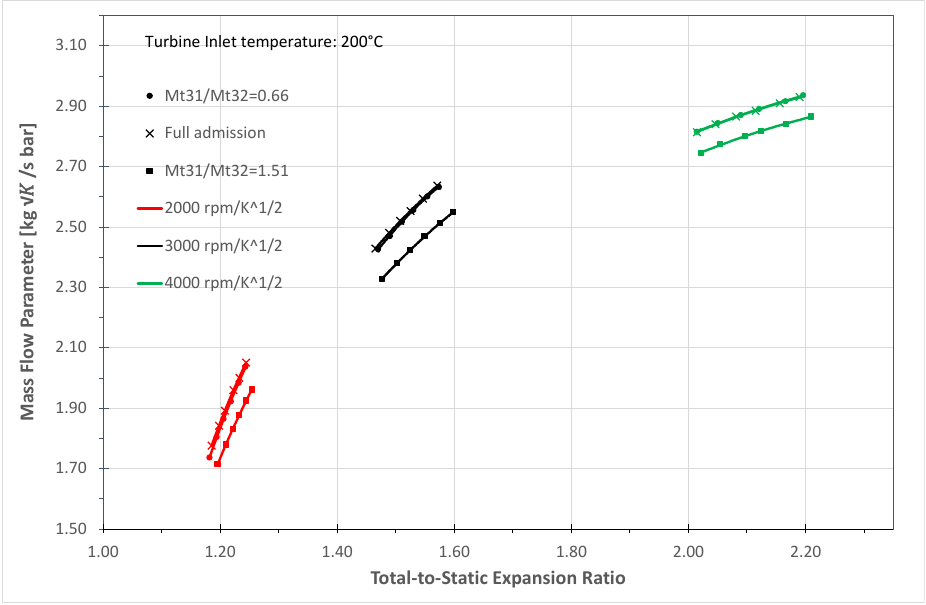
Figure 9. Comparison between MFP under full, Mt31/Mt32 = 0.66, and Mt31/Mt32 = 1.51 admis- sion conditions.